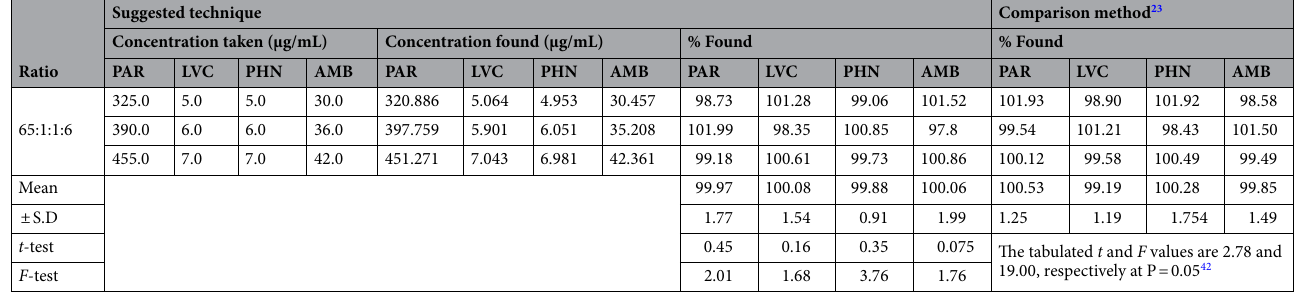
Table 6. Assay results for the determination of four studied drugs in their co-formulated prepared tablet by the suggested HPLC technique.